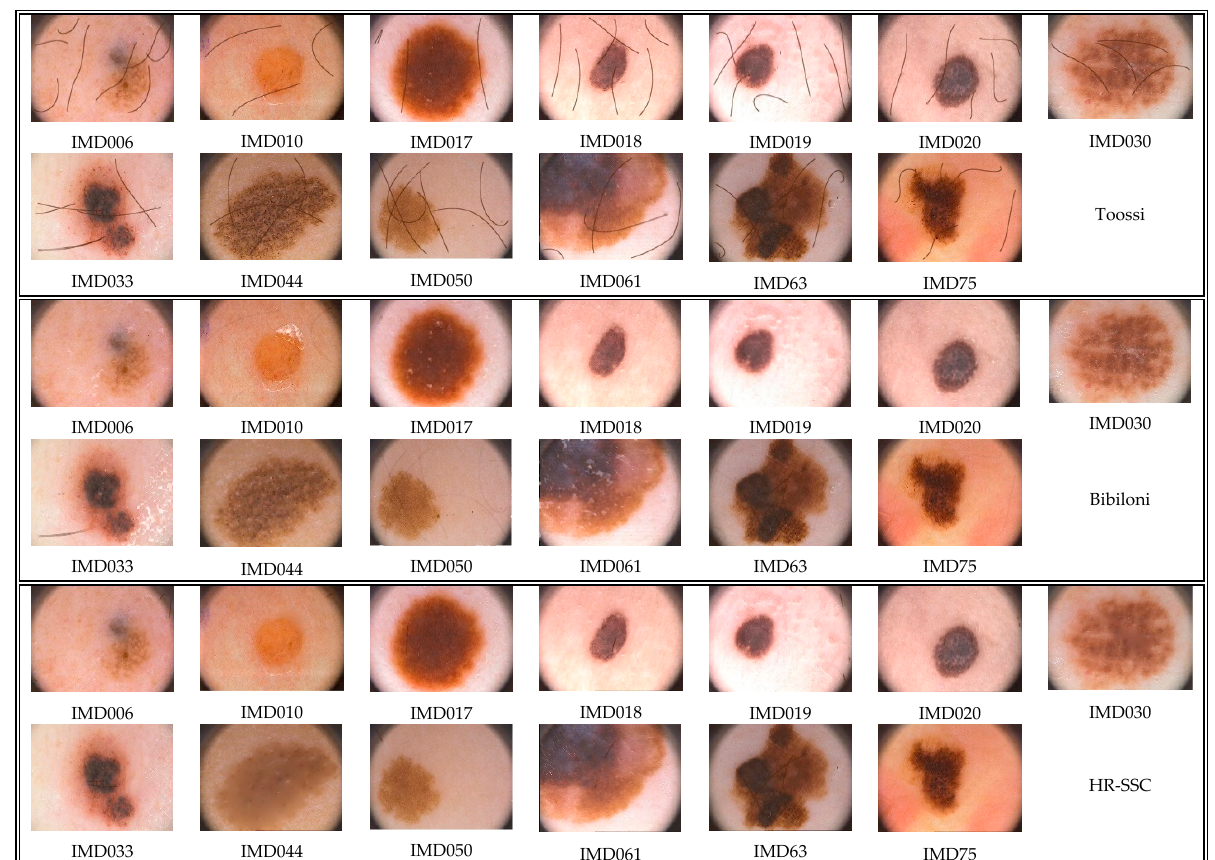
Figure 11. ( a ) Results of methods Lee, Xie, Abbas, Huang available in [37], rows 1–4, on H13Sim-data. ( b ) Results of method Toossi, Bibiloni available in [37], rows 1–2, and results of HR-SSC, row 3, on H13Sim-data.